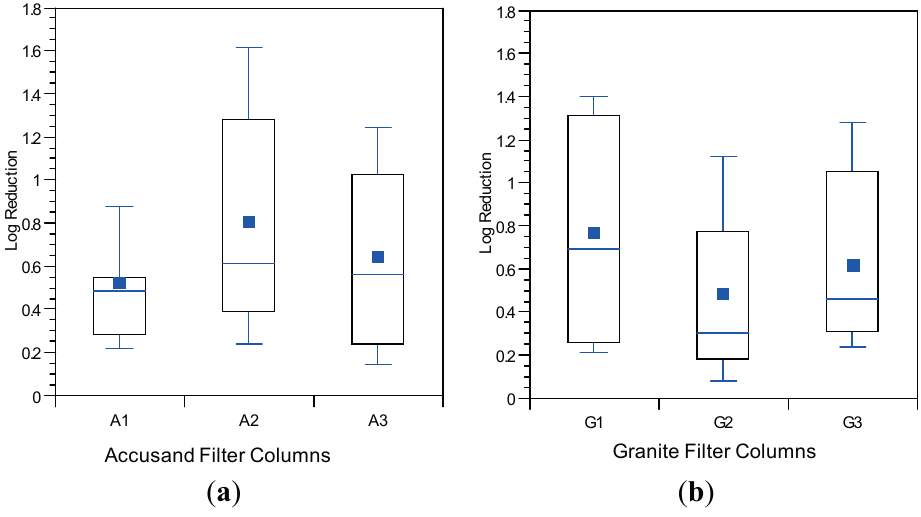
Figure 11. MS2 reductions for ( a ) Accusand media columns; and ( b ) granite media columns in Column Test No. 2 for samples collected throughout the eight-week experiment. N = 13 for G2; 14 for A1–A3; 15 for G1 and G2.